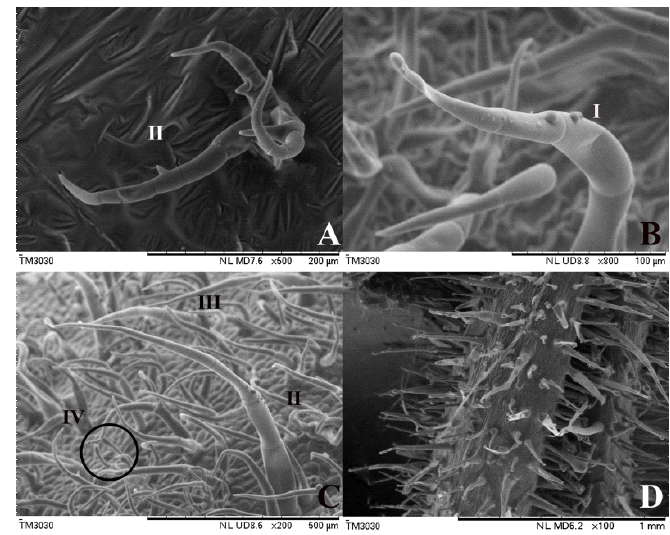
Figure 1. Morphological observation of different types of trichomes of tomato 3186M (tomato wo mutant, hairy) under a scanning electron microscope. The gross state of the trichomes of 3186M was observed by scanning electron microscopy, and different types of trichomes are marked in the picture. Scale bars ( A ) = 200 µ m, ( B ) = 100 µ m, ( C ) = 500 µ m, ( D ) = 1 mm.